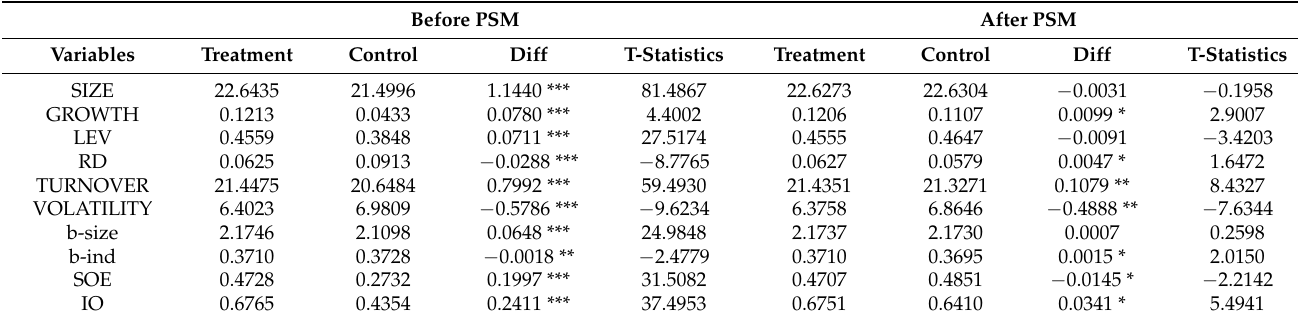
Table 2. Propensity score matching (PSM) results.